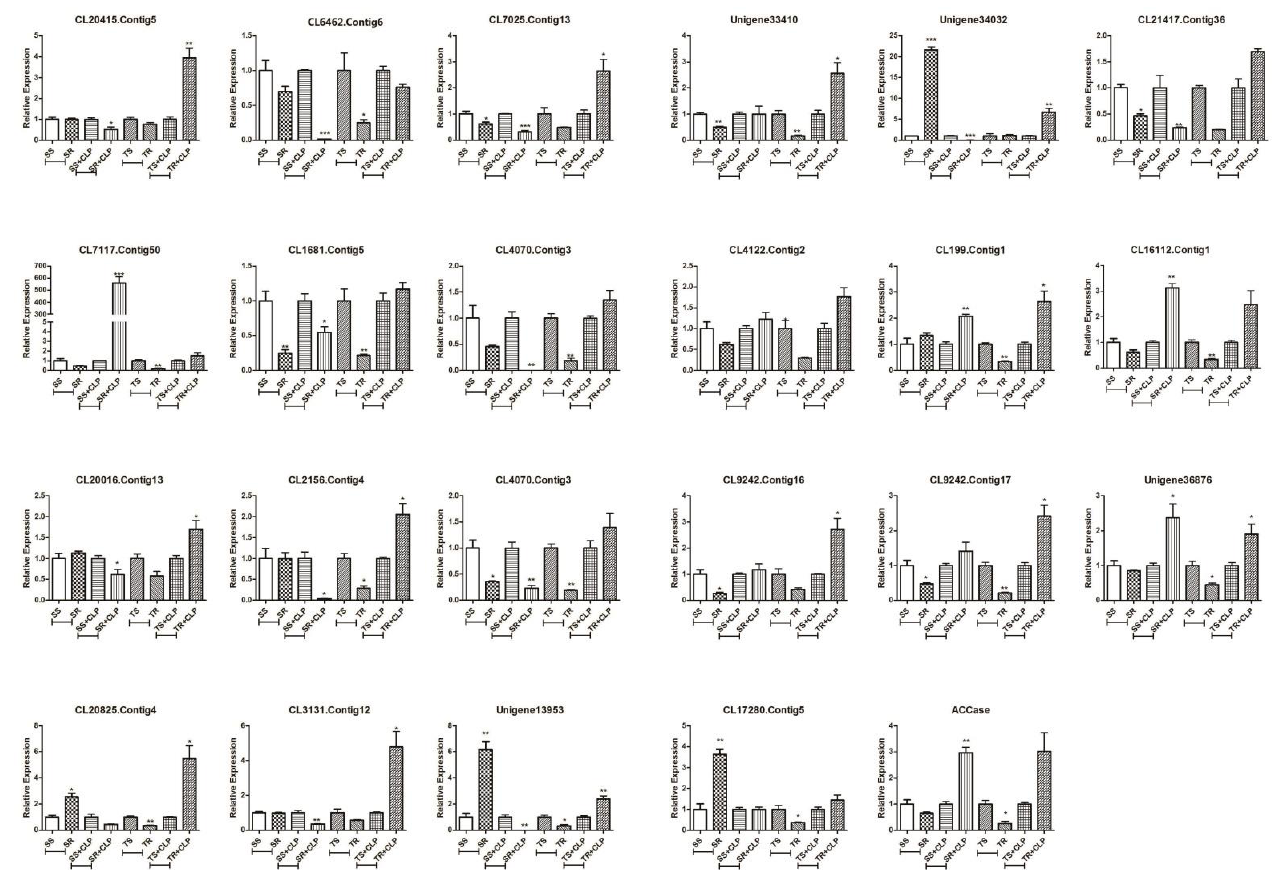
Figure 3. qRT-PCR validation of candidate NTSR gene expression between resistant and susceptible population. Three replicates were performed for each of the three biological replicates. The standard error of the mean is shown by the error bars. SS: susceptible population in the seedling stage; SR: resistant population in the seedling stage; TS: susceptible population in the tillering stage; TR: resistant population in the tillering stage; +CLP: application of clodinafop-propargyl. * p < 0.05, ** p < 0.01, *** p <